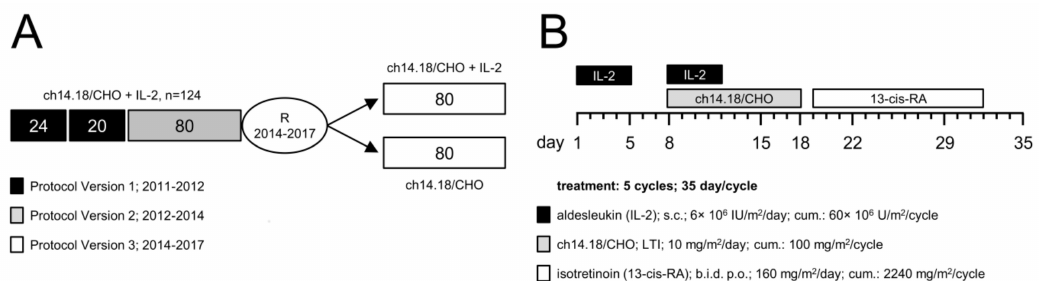
Figure 1. Schematic overview of the treatment schedule and the time line of the LTI study. ( A ) The LTI study (EudraCT-Number: 2009-018077-31) was planned as a single-arm study and amended in 2014 to address a randomized question. From 2011 to 2014, 124 pts were recruited in the single-arm phase, and 2 × 80 pts were recruited from 2014 to 2017 in the randomized phase. The single-arm phase consisted of a dose-finding (protocol version 1; 24 + 20 pts) and a dose confirmation cohort (protocol version 2; 80 pts), leading to a total of 124 pts in that part or the trial; ( B ) 122 of 124 enrolled NB pts received up to five treatment cycles (35 d/cycle) according to the following treatment protocol (2 pts progressed prior to first antibody application): IL-2 (aldesleukin; black horizontal bar) was given once a day for five days (s.c., d1–5, 6 × 10 6 IU/m 2 /d), followed by a combined application of IL-2 once a day (s.c., d8–12, 6 × 10 6 IU/m 2 /d) with a 10 days continuous infusion of ch14.18/CHO (i.v., d8–18, 10 mg/m 2 /d; grey horizontal bar). Starting on d19, treatment was continued with 13-cis-retinoic acid (isotretinoin; white horizontal bar) given twice a day (b.i.d) for the next 14 days (p.o., d19–32). Cumulative doses of IL-2, ch14.18/CHO and 13-cis-RA per cycle were 60 × 10 6 IU/m 2 , 100 mg/m 2 and 2240 mg/m 2 ,